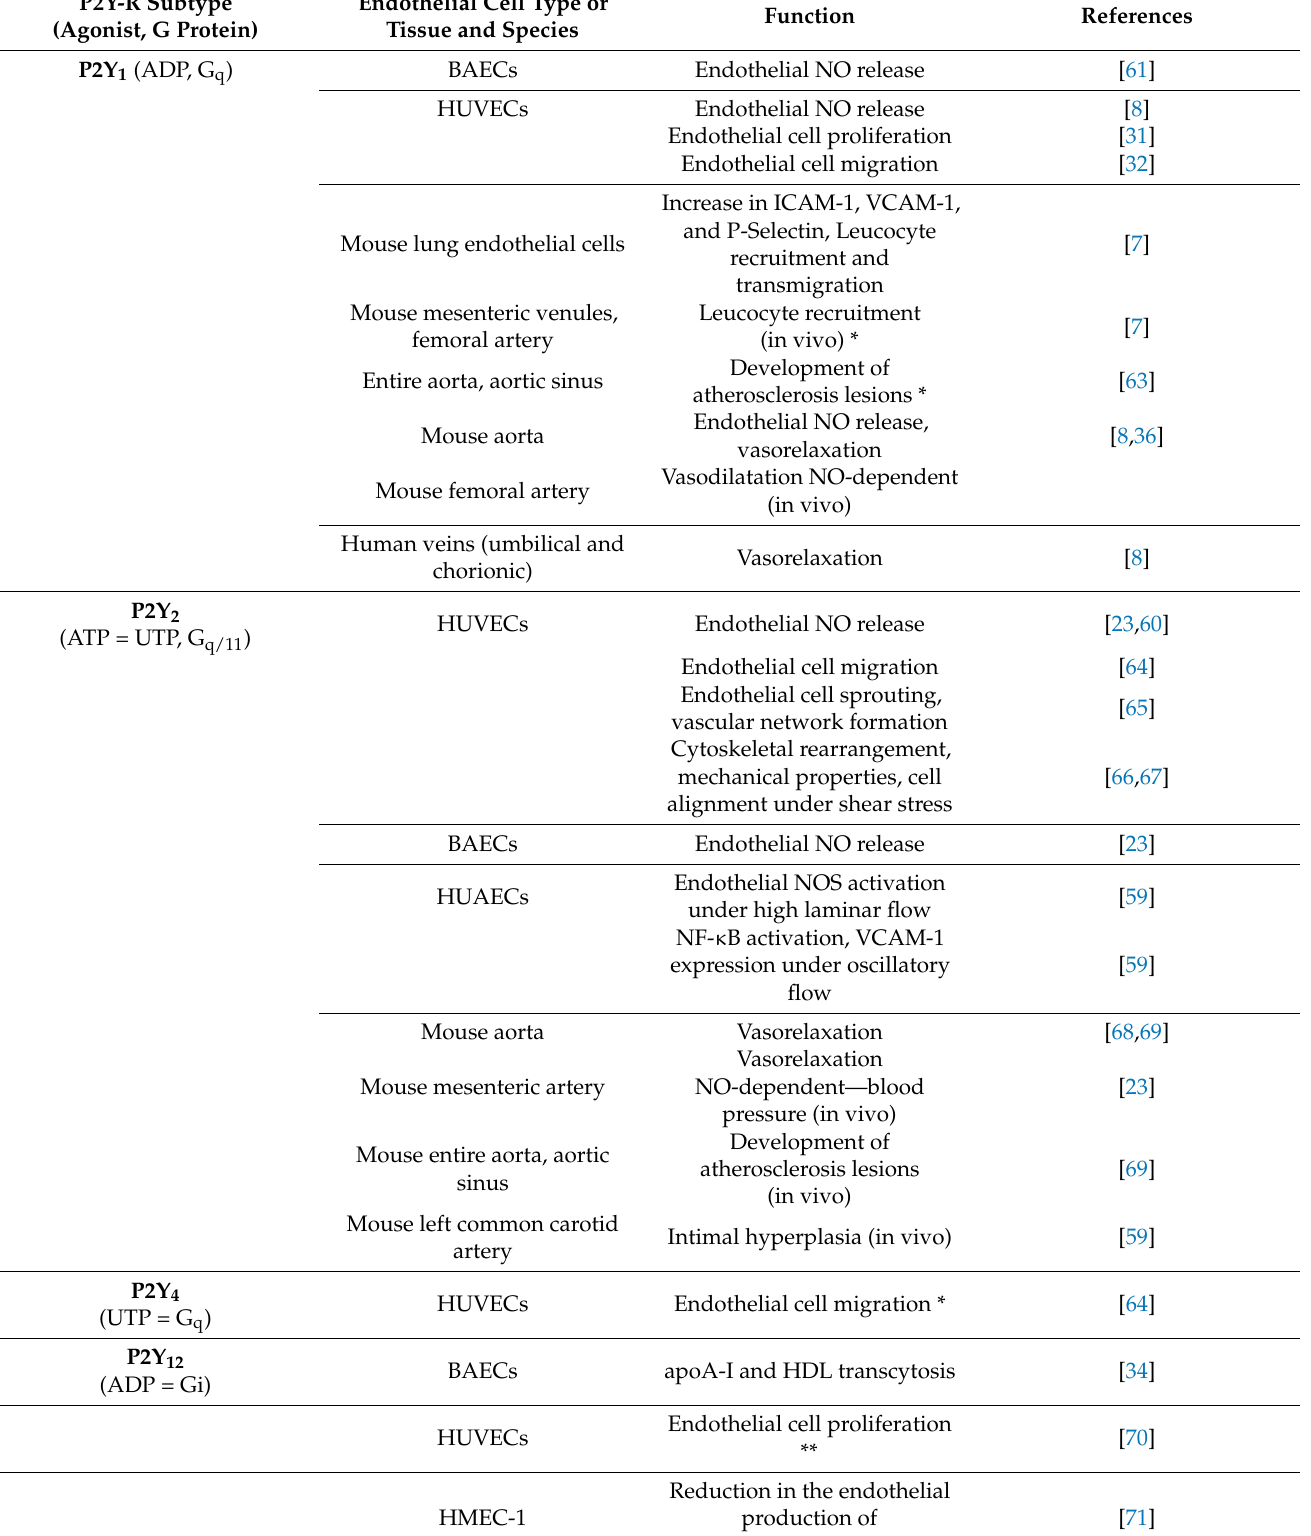
Table 1. Functions of P2Y receptors in endothelial cells and